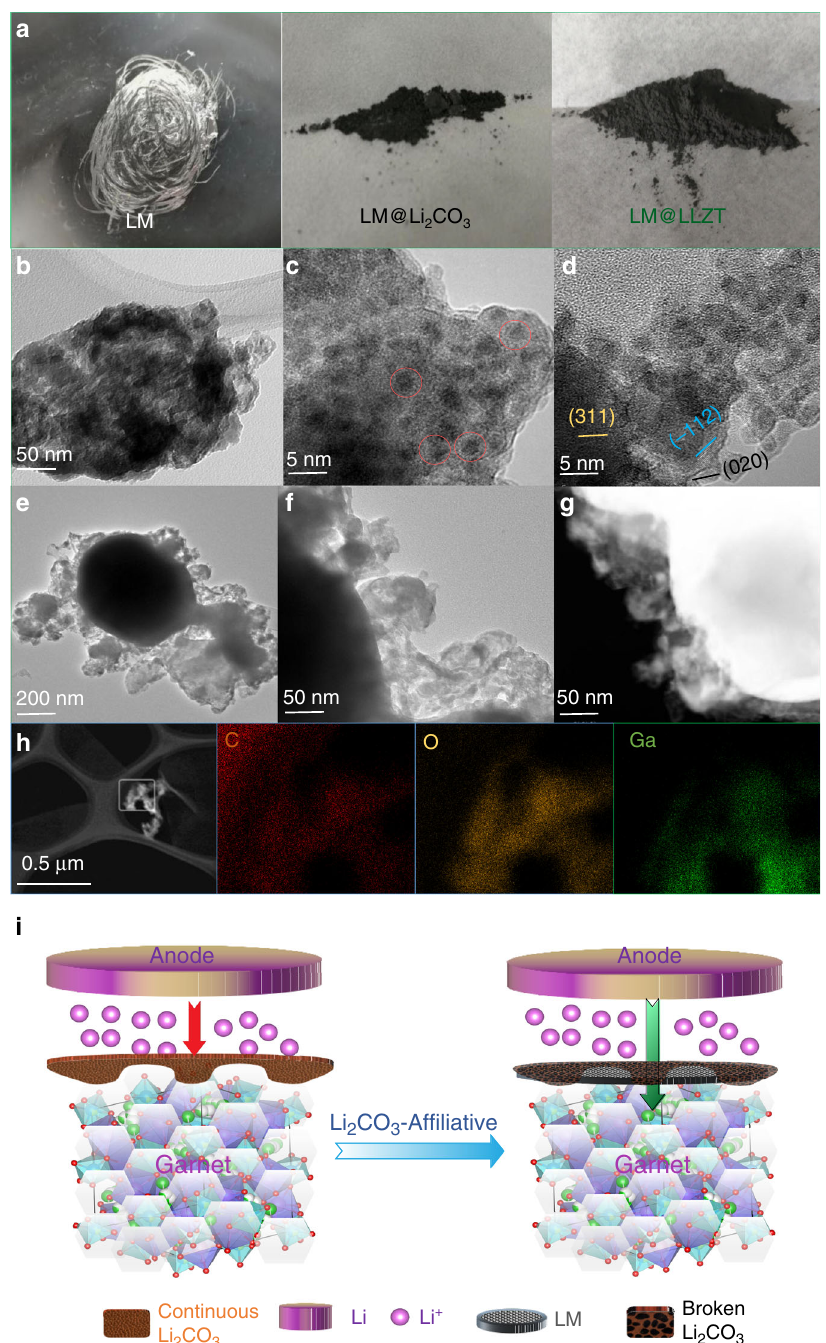
Fig. 3 Con fi rmation of Li 2 CO 3 -af fi liative mechanism via blending with LM. a Photos of liquid gallium after grinding in air environment and its mixtures with Li 2 CO 3 powder and cubic garnet powder. b TEM image of Li 2 CO 3 powder with the embedment of liquid metal domains. c , d HRTEM of well-mixed LM and Li 2 CO 3 nanodomains in different zones. e TEM image of interfacial contact between excess liquid metal and Li 2 CO 3 and ( f ) its magni fi ed region to disclose the af fi liative interface of LM-Li 2 CO 3 . g HADDF image of interfacial situation between LM sphere and Li 2 CO 3 moieties. Liquid metal including in its oxide skin is bright while the rest part is Li 2 CO 3 powder. h STEM and corresponding EDS mapping images of C, O, Ga elements. i Schematic comparison of Li-ion interface transfer across continuous Li 2 CO 3 layer and across broken Li 2 CO 3 network wetted with liquid